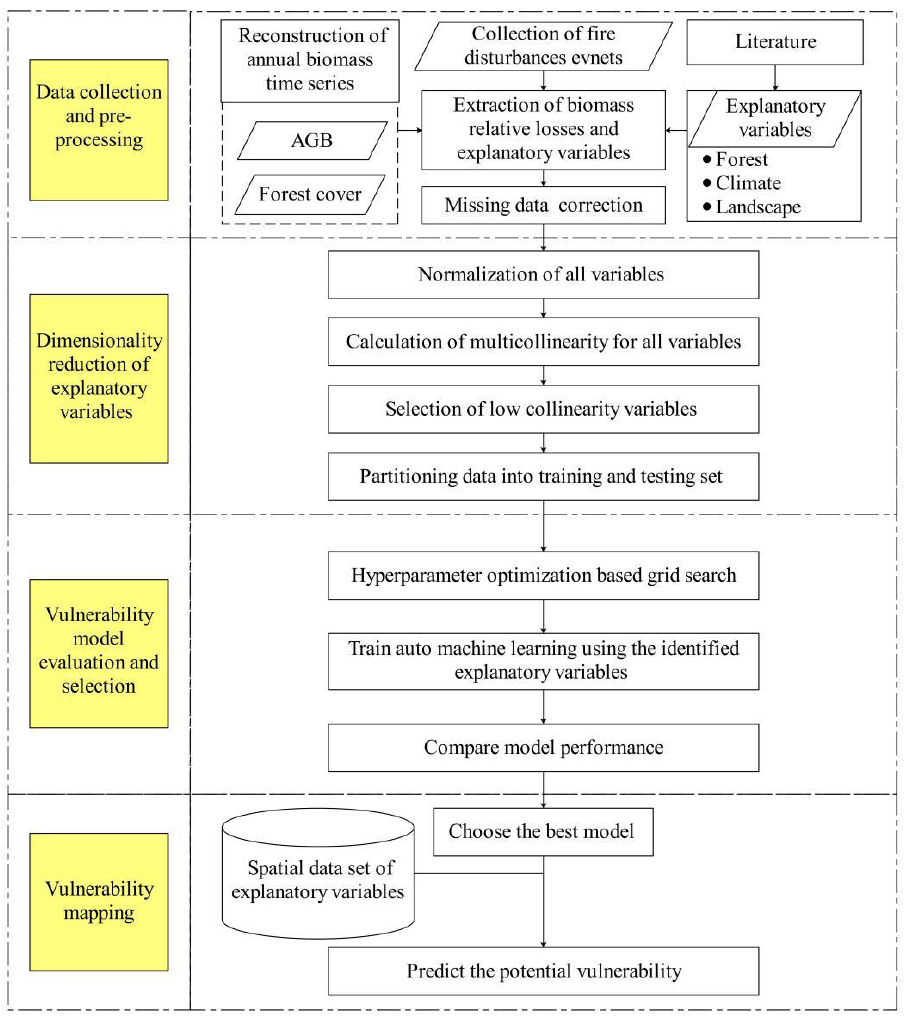
Figure 2. Methodology scheme and workflow.